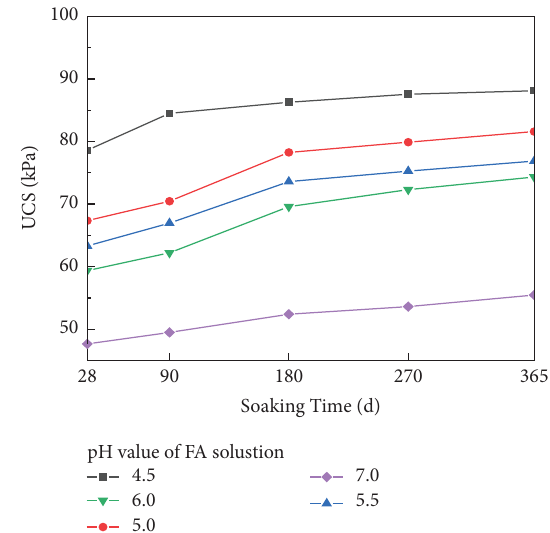
Figure 6: Relation curve between sample UCS and soaking